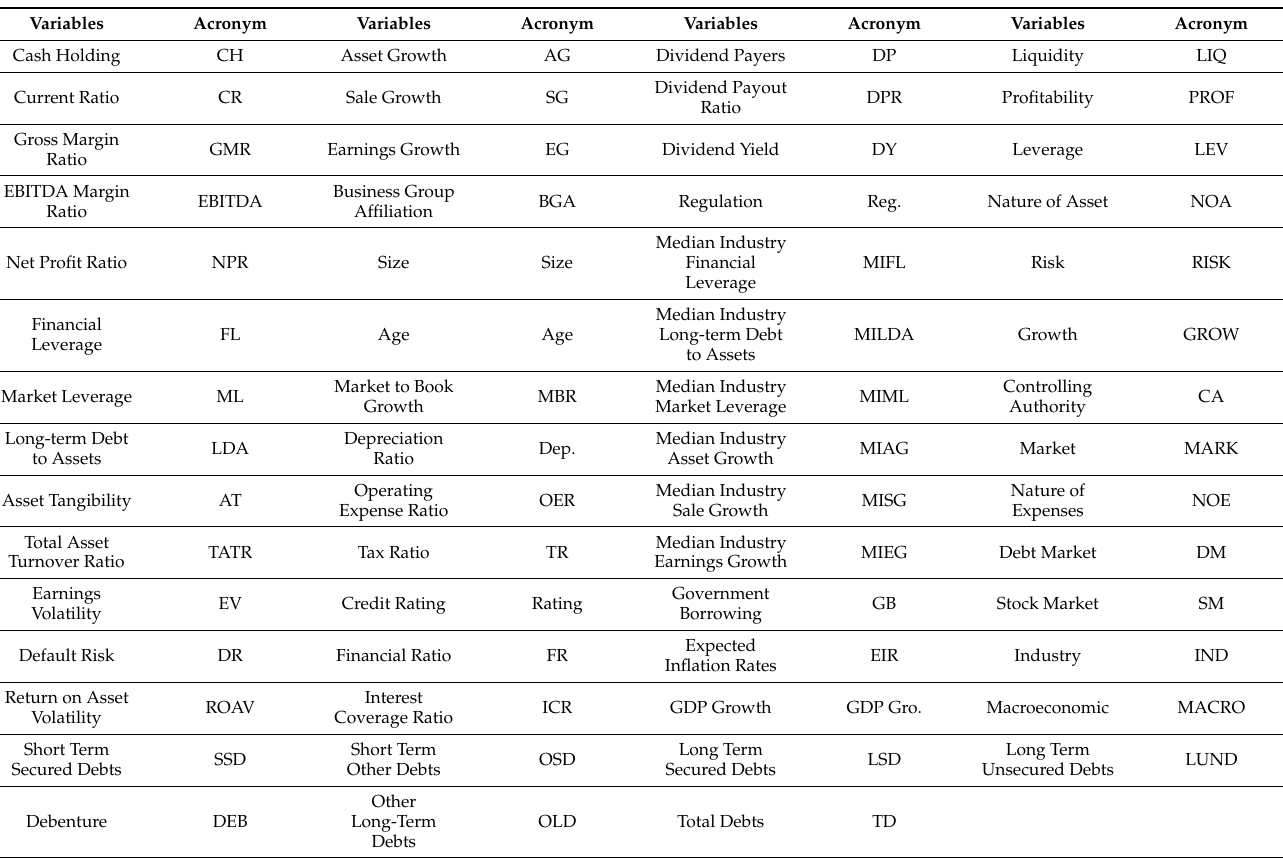
Table A1. Table of